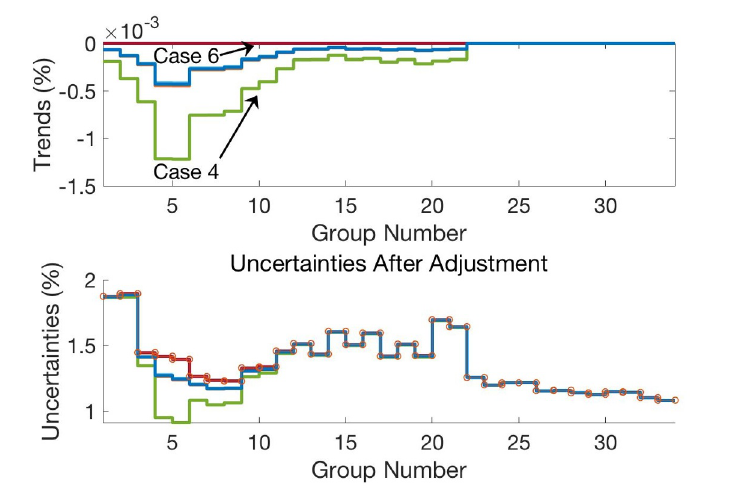
Figure 5. Adjusted Pu239 ¯ ν data (trends and uncertainties) for all 7 sub-cases